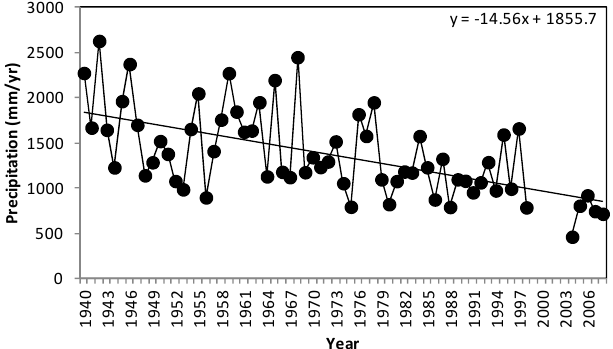
Figure 2. Evolution of annual precipitation in the past seven decades in the Vila Pouca de Aguiar municipality. The precipitation data were compiled from the Portuguese Water Institute (https://snirh. apambiente.pt) and refer to National station